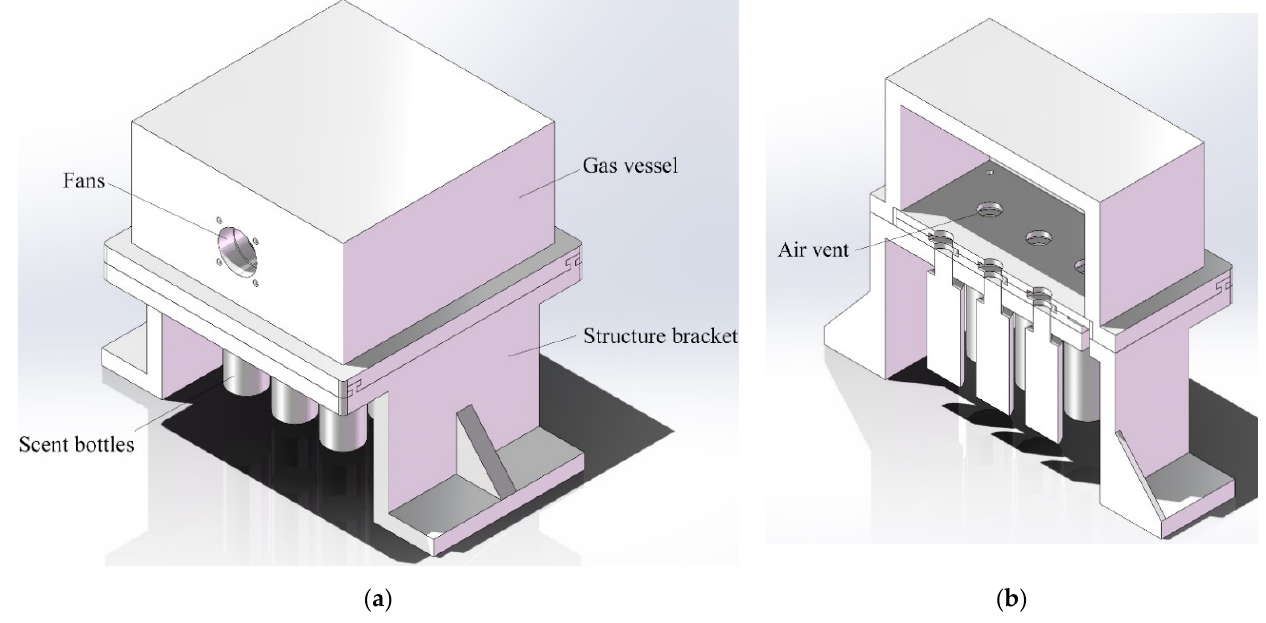
Figure 2. Scheme of the device framework: ( a ) isometric view; ( b ) section view.